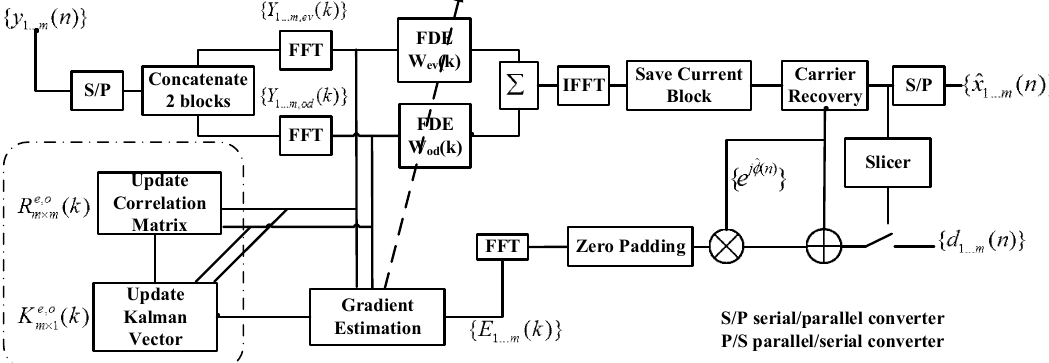
Figure 15. Block diagram of recursive least square (RLS) frequency domain equalization (FDE) for m-dimension system operating on two samples per symbol.